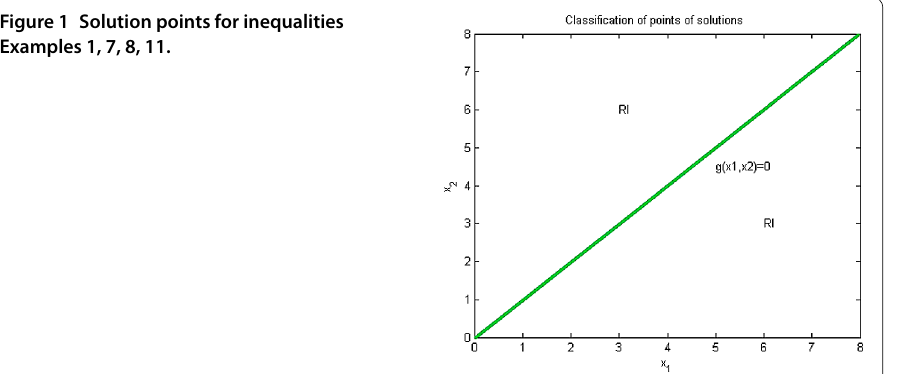
Figure 1 Solution points for inequalities Examples 1, 7, 8,